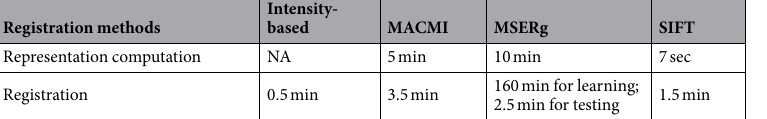
Table 2. Computational efficiency including the image representation calculation and registration time consumption. Although MSERg has a higher computational cost during the learning step, this burden can be greatly reduced via parallel computing because all the single-scale representation registrations are essentially independent of each other, with no